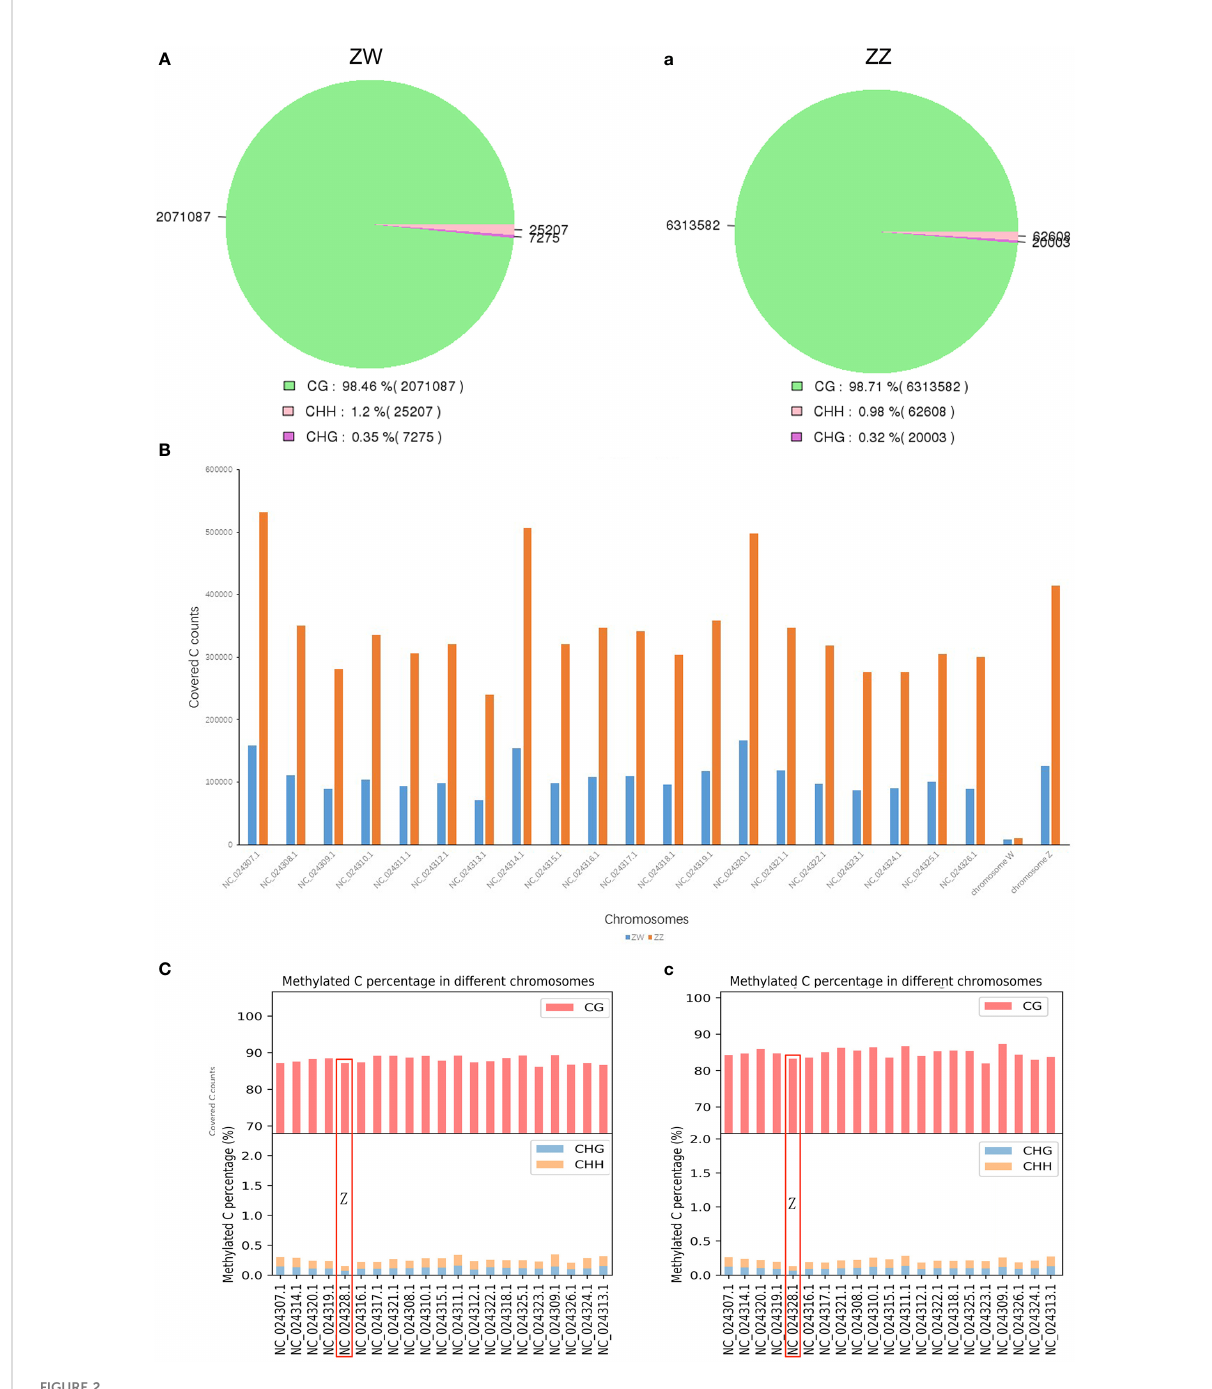
FIGURE 2 Genome-wide DNA methylation and methylated C site detection on chromosomes. (A) Contexts of methylation C site (CG, CHH, CHG) of DNA methylome in ZW group. (a) Contexts of methylation C site (CG, CHH, CHG) of DNA methylome in ZZ group. (B) Number of covered C annotated on W chromosome of both ZW and ZZ groups. (C) Percentage of Methylated C site distributed on each chromosome in ZW group. (c) Percentage of Methylated C site distributed on each chromosome in ZZ